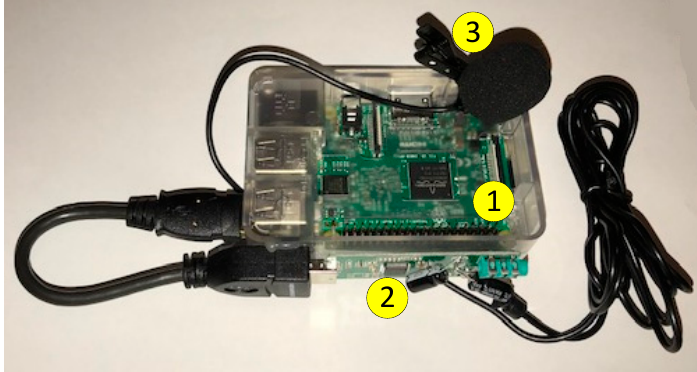
Figure 9. Photograph of the listener module—(1) Raspberry Pi; (2) Sound card; (3) Microphone.